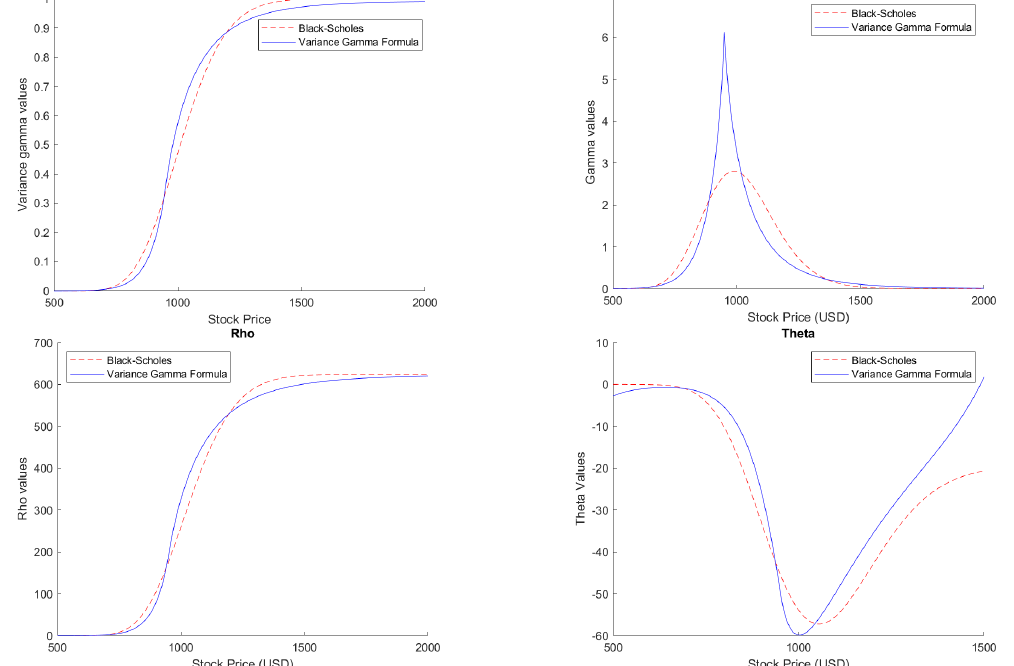
Figure 3. Greek functions under the Black–Scholes and Variance Gamma models, for K = 1100 and τ = 35 ×